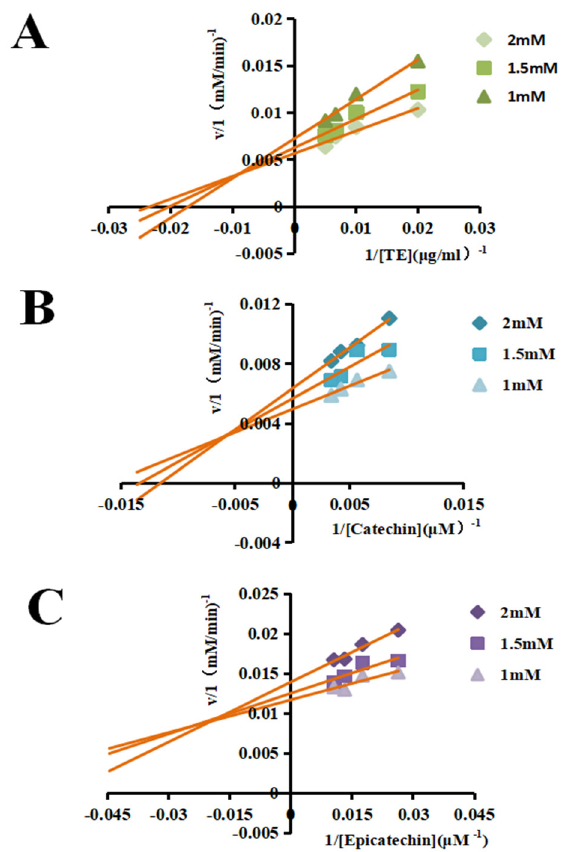
Figure 5. Experiments similar to the Lineweaver-Burk method were used to evaluate the activity of the samples against tyrosinase. The substrate consisted of TE ( A ), (+)-Catechin ( B ), ( − )-Epicatechin ( C ), and concentrations of L ‐ DOPA for each plot were 1, 1.5 and 2 Mm.